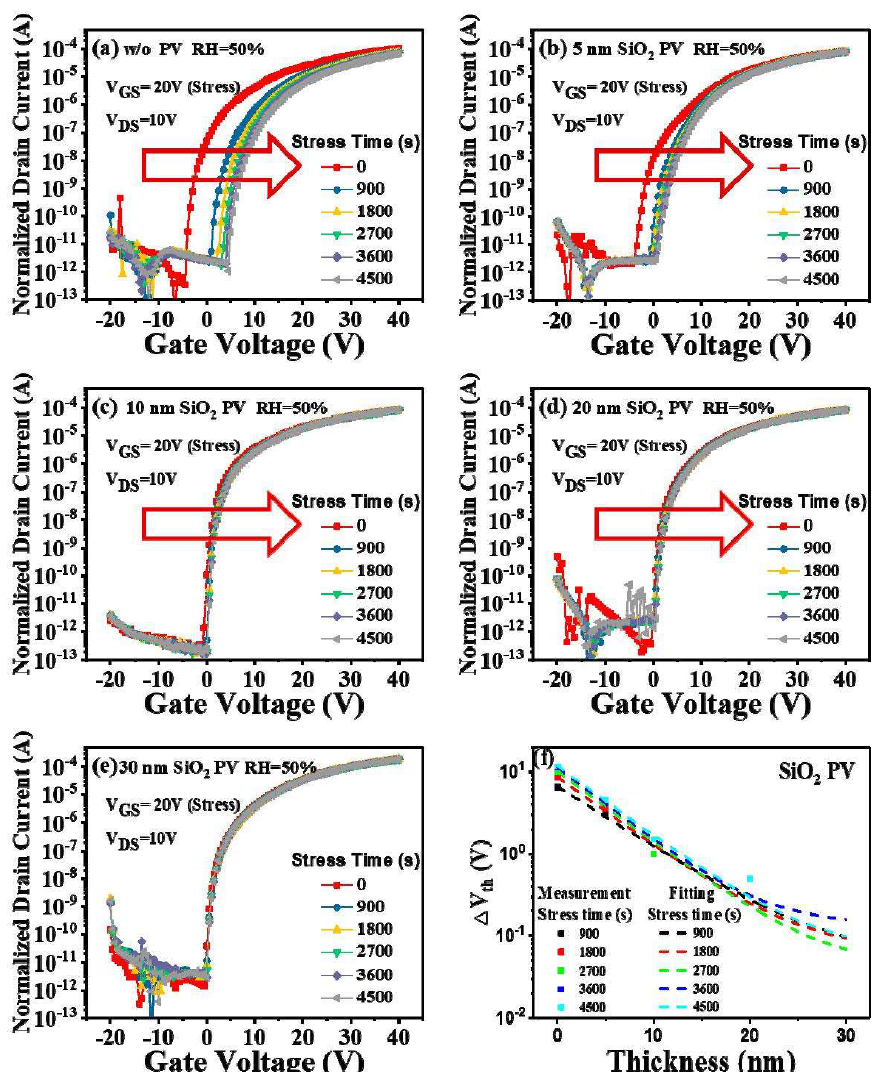
Figure 4. Stress-time dependence of the transfer characteristics of the a-IGZO TFTs with a SiO 2 PV layer thickness of ( a ) 0 nm, ( b ) 5 nm, ( c ) 10 nm, ( d ) 20 nm, and ( e ) 30 nm, respectively; ( f ) experimental